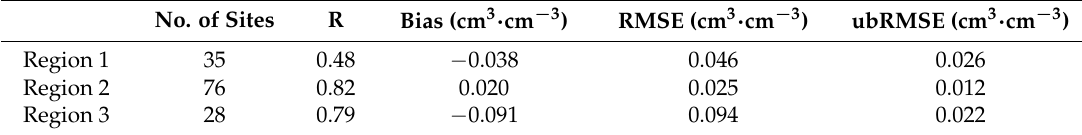
Figure 7. Comparison between the SMAP L3 SM product and the in situ SM observations over ( a ) region 1, ( b ) region 2, ( c ) region 3. 30 pairs of 7-day averaged data were used from 1 April 2016 to 30 September 2016. Table 1. Statistics of comparison between the SMAP L3 SM product and the in situ SM observations in each of the 3 regions (1 April 2016–30 September 2016).